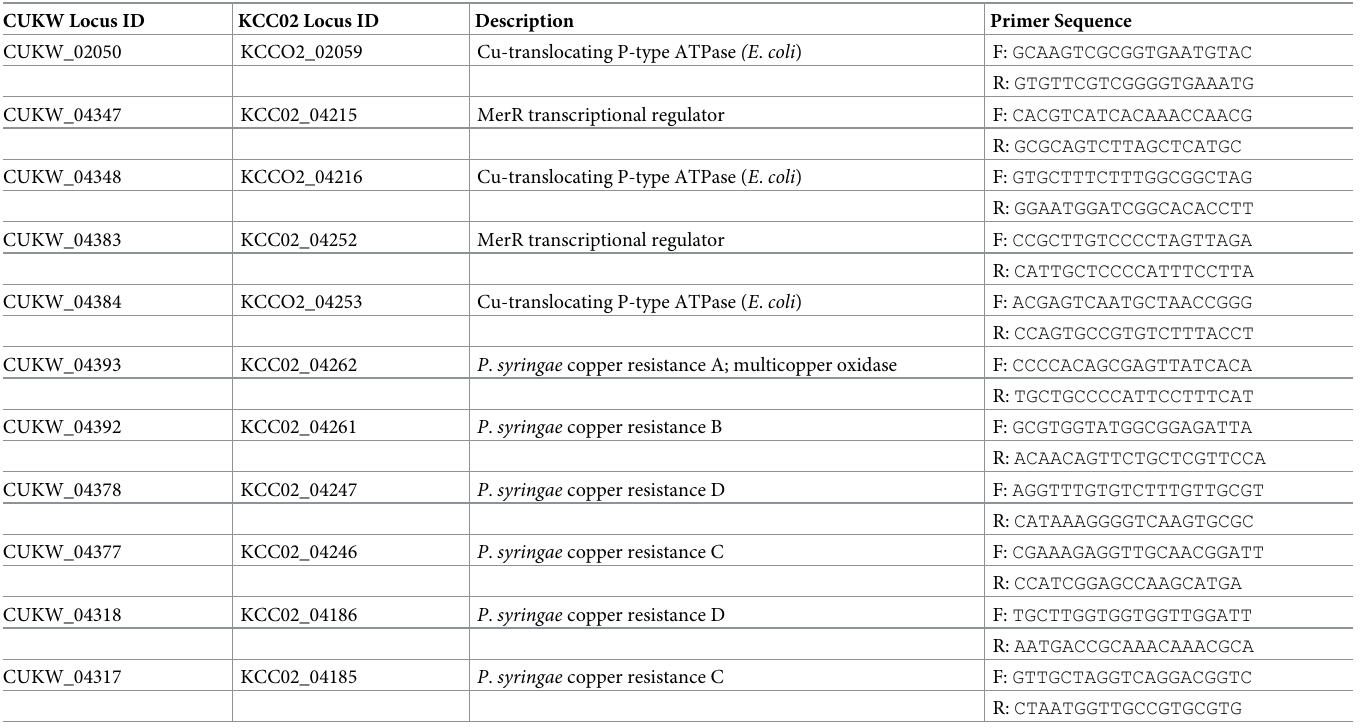
Table 3. Copper-associated genes used in expression